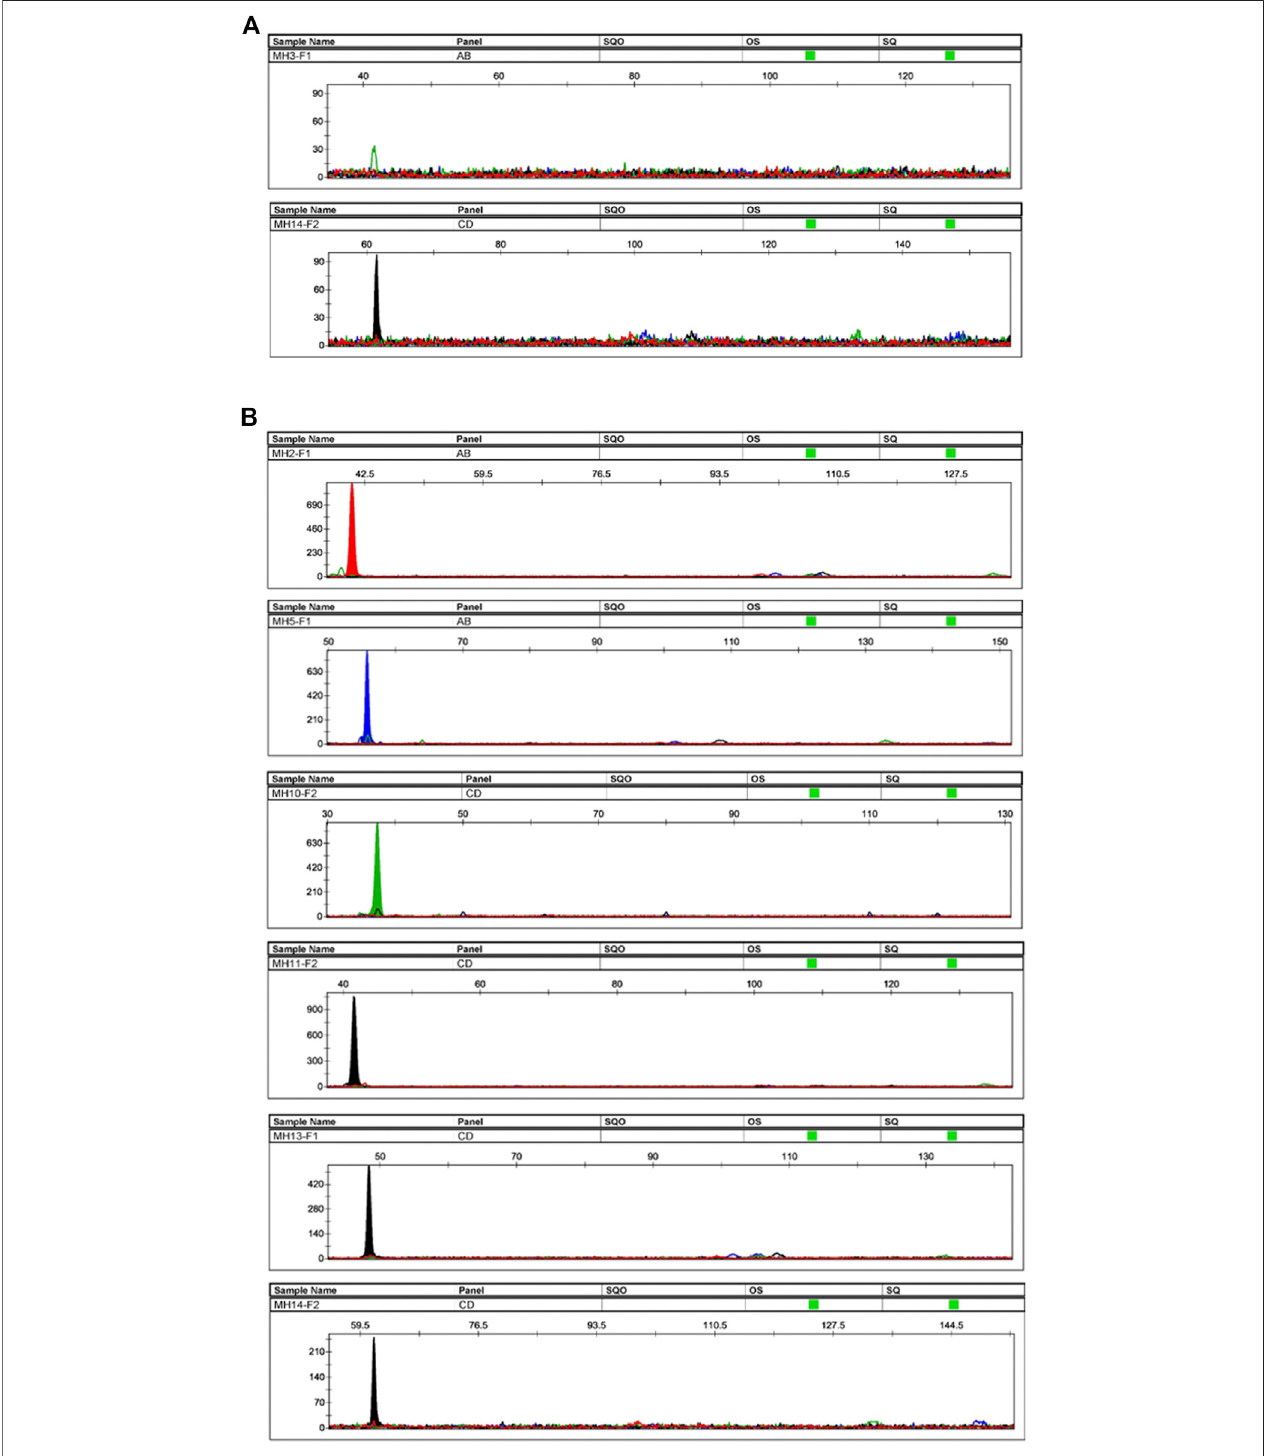
FIGURE 6 | Plasma samples ’ pro fi les. (A) Pro fi les of the plasma sample from family No. 2. The sample had two informative alleles, but only MH14-F2 displayed a positive result. The peak height of MH3-F1 did not reach the threshold, and the fetal DNA was not successfully genotyped. (B) Pro fi les of plasma sample of family No. 6. The sample had six informative alleles, and all loci displayed positive results.